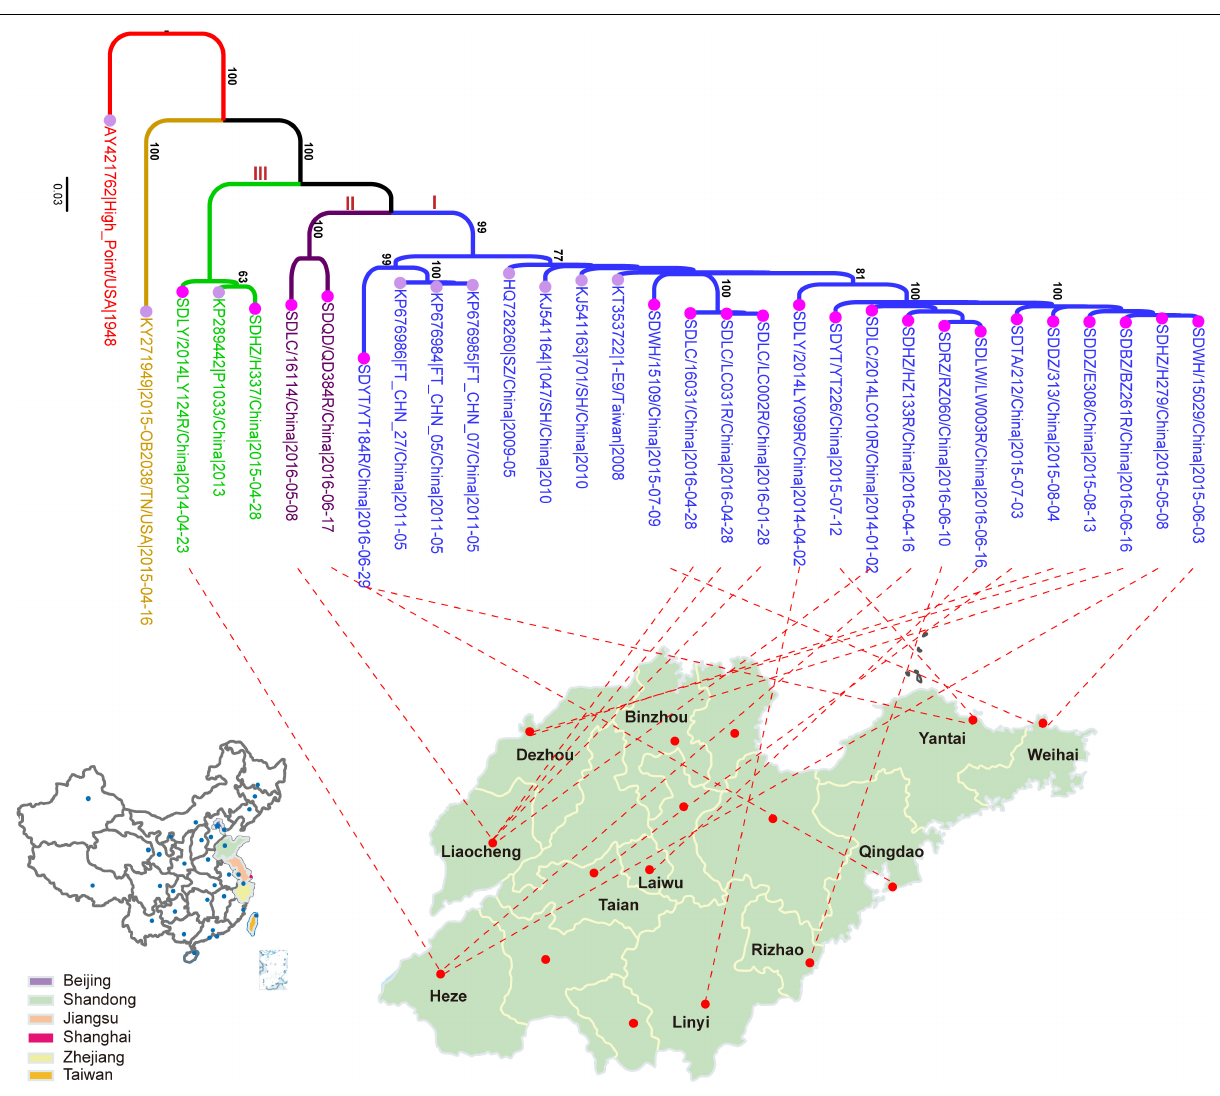
FIGURE 1 | The maximum likelihood phylogenetic tree of the CVA4 whole genome sequences ( n = 31). The 21 CVA4 isolates described in this study are colored in rose and the nodes of the reference stains downloaded from GenBank are colored in lavender. The three clades (I, II, and III) are colored in blue, purple and light green, and the prototype strain CVA4 High Point (AY421762) is colored in